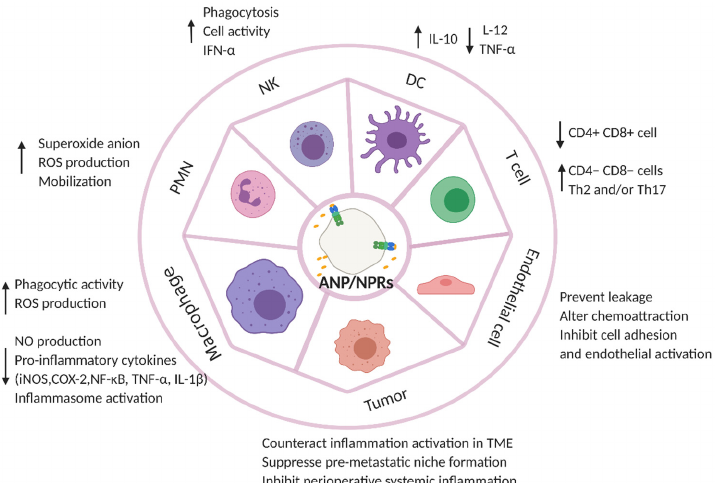
Figure 3. Immunomodulatory effects of ANPs. ANPs potentiate superoxide anion secretion, ROS production, and the mobilization of prime polymorphonuclear neutrophils (PMNs); ANPs tightly regulate the activity of macrophages, enhancing phagocytic activity and ROS production on the one hand, while reducing the production of NO and pro-inflammatory cytokines (iNOS, COX-2, TNF α , NF- κ B, and IL-1 β ) and inhibiting inflammasome activation on the other hand. ANPs increase phagocytosis, cell activity, and the IFN- α release of nature killer (NK) cells; ANPs regulate maturation and differentiation of dendric cells (DCs) and promote anti-inflammatory cytokine (IL-10) release, but they inhibit pro-inflammatory cytokine (IL-12 and TNF- α ) secretion. For adaptive immunity, ANPs decrease the percentage of CD4 + CD8 + thymocytes and increase the CD4 − CD8 − cell population. In addition, ANPs alter DC differentiation and subsequently polarize naive CD4 + cells toward the Th2 or Th17 phenotypes. ANPs protect endothelial barrier function, prevent leakage, alter chemo- attraction and cell adhesion, and inhibit endothelial activation. ANPs counteract the occurrence of